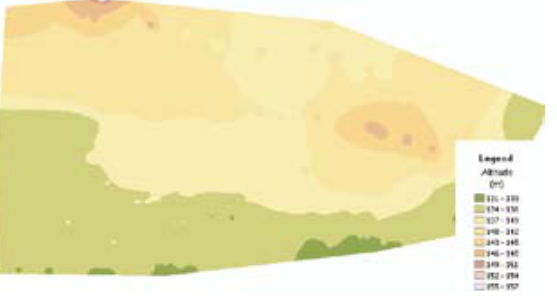
Fig. 4. DEM created by regularized spline method